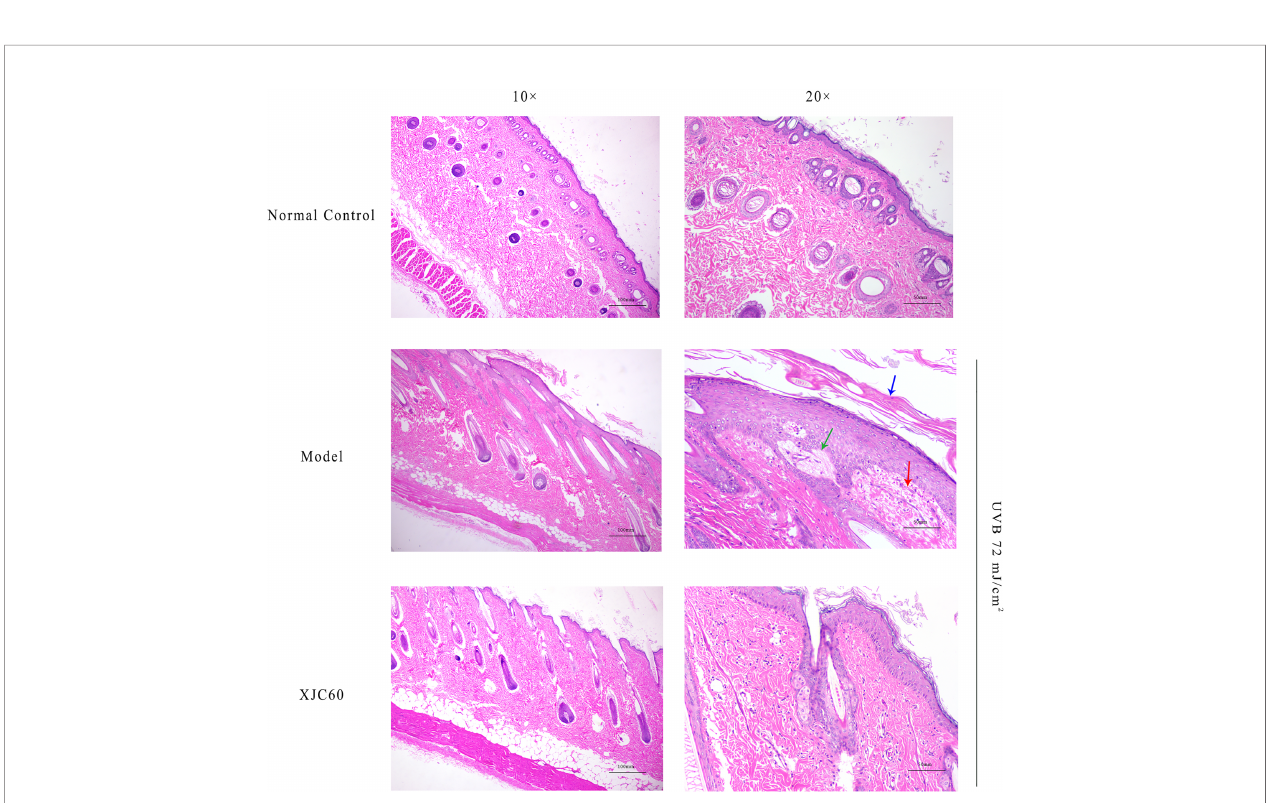
FIGURE 6 | In vivo antiphotoaging effects of Limosilactobacillus fermentum XJC60. (Normal control) Left: smooth stratum corneum and obvious keratinized beads (10×); right: no in fl ammatory cell in fi ltration or cell necrosis was detected (20×). (Model) Left: abnormal keratinization in the skin of Guinea pigs, with obvious proliferation (10×); right: visible epithelial edema and mild cell necrosis (20×). Blue arrow: keratinization; green arrow: epithelial edema; red arrow: cell necrosis. ( L. fermentum XJC60) Left: the skin tissue structure was relatively complete, keratinization of the skin was reduced, and keratinization beads were being repaired (10×); right: no in fl ammatory cell in fi ltration or cell necrosis were observed